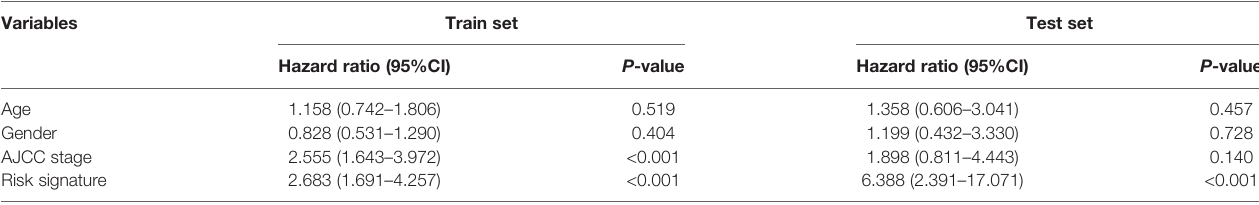
TABLE 1 | Multivariate analysis of impact on patient survival of risk signature, age, gender and AJCC stage. Variables Train